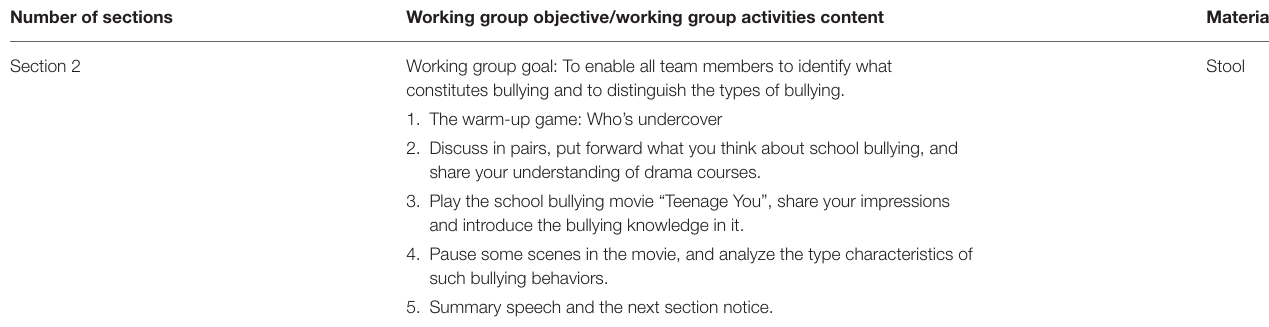
TABLE 4 | Campus bullying identification